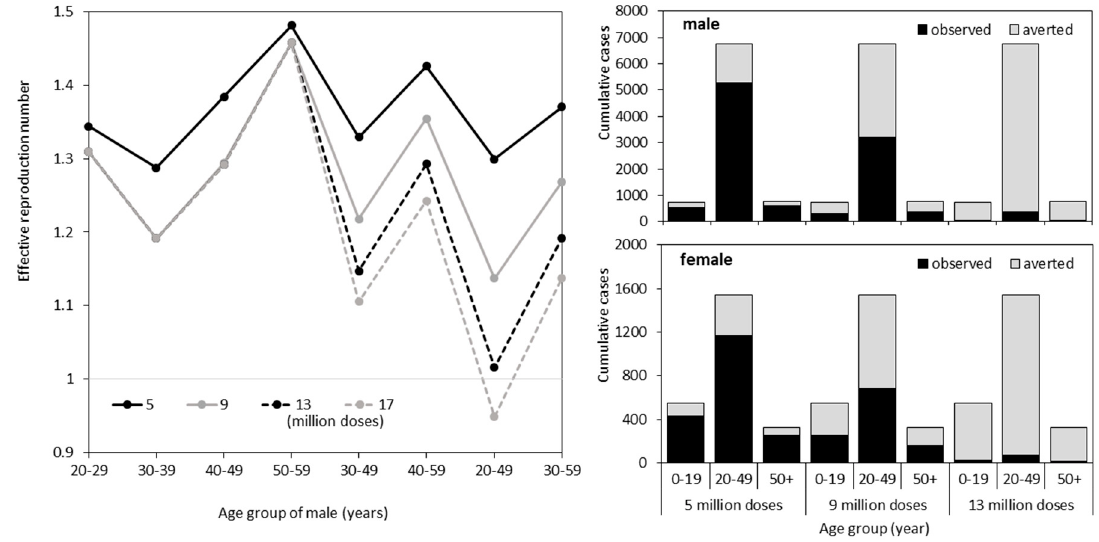
Figure 3. Supplementary immunization programs (SIPs) among di ff erent age groups. ( A ) E ff ective reproduction numbers under di ff erent SIP scenarios, varying doses and subjects. Resulting estimates using an identical dose are connected by lines. A gray horizontal axis shows a threshold value ( = 1) below which a major epidemic is prevented. ( B , C ) The cumulative numbers of rubella cases associated with di ff erent SIP are shown for each age group for males and females, respectively. Assuming that the SIP was conducted in males aged from 20–49 years, the cumulative number of cases was calculated. Black bars represent the expected number of cases under di ff erent SIP scenarios, and gray bars represent cases averted by the SIP.